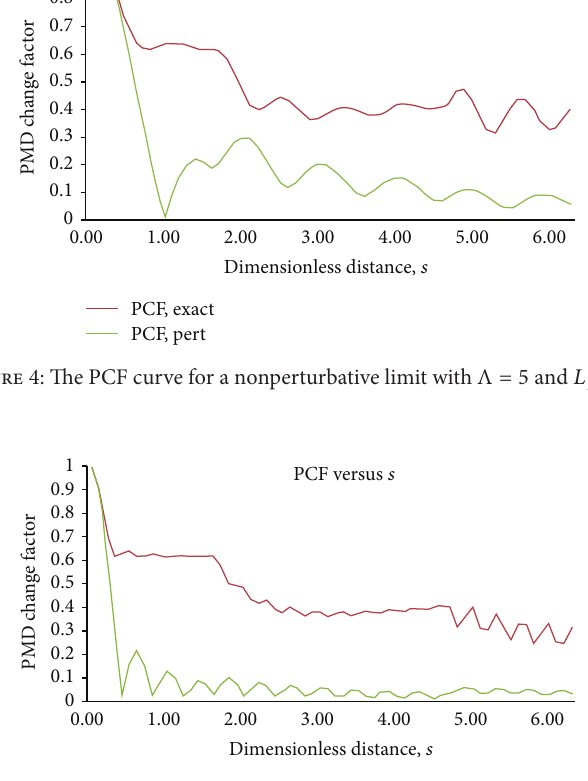
The top and bottom curves in Figure 4 show exact and perturbative calculations, respectively. It is seen that perturbative approximation underestimates the PCF in this regime. The two start diverging significantly for value of 𝑠 a little less than 1.